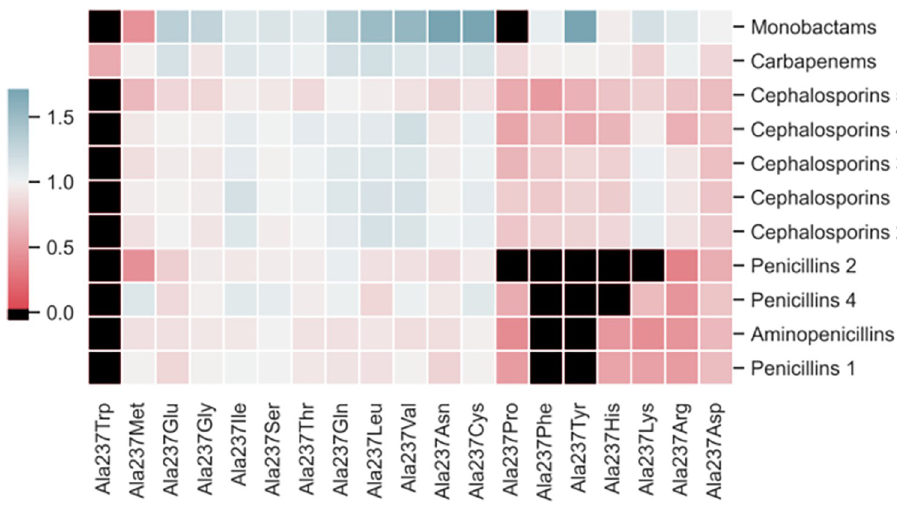
Fig 3. Clustered heatmaps of relative docking scores for each drug class against TEM β -lactamase structures harboring mutations in active site residue alanine 237. Black indicates that no favorable poses were found, suggesting that the ligand was unable to bind. Docking scores are normalized with respect to the wild-type docking score.